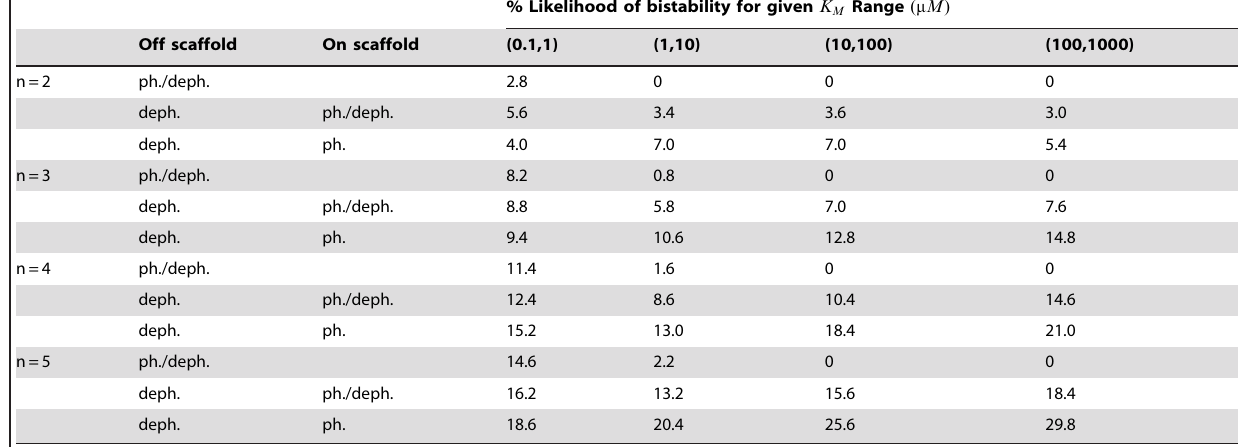
% Likelihood of bistability for given K M Range ( m M )